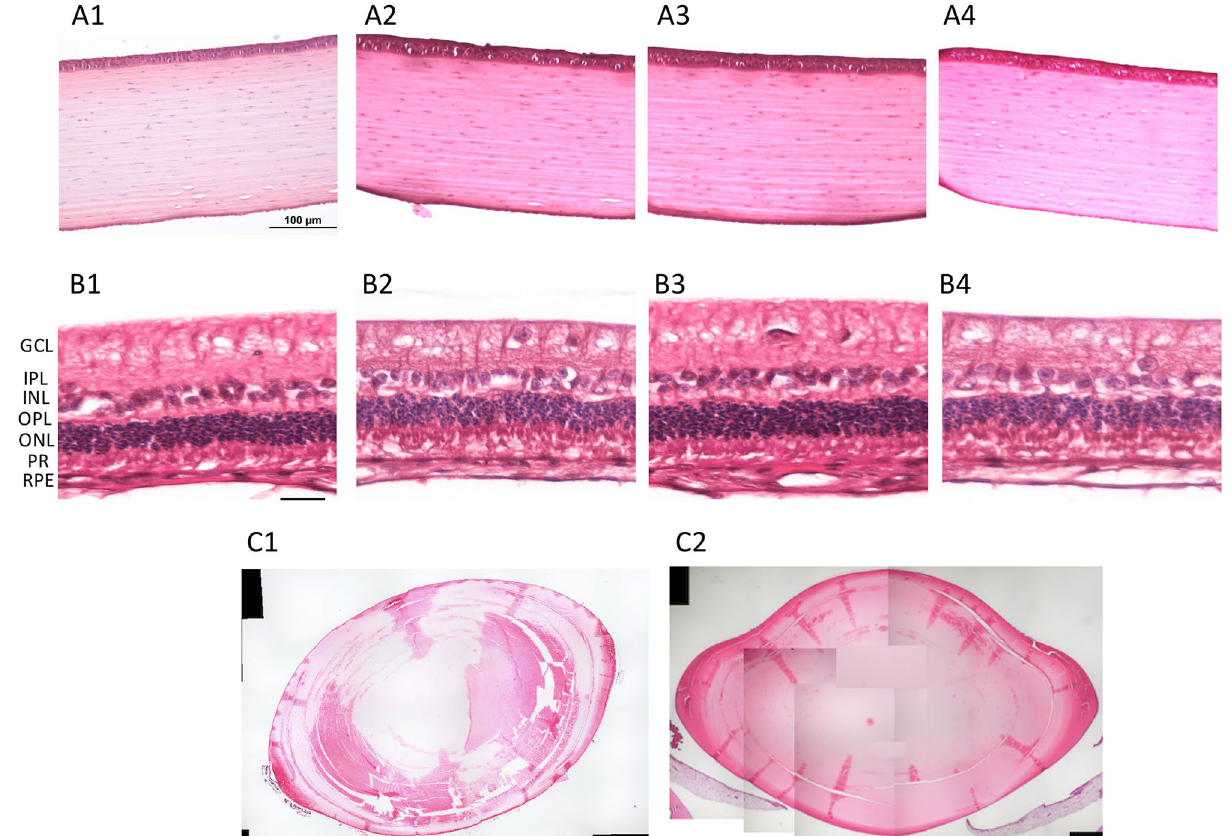
Figure 6. Histological sections with H&E staining presented that no inflammatory cell infiltrates or fibrotic reaction in the corneal stroma ( A1 – A4 ), and no retinal pathology such as gliosis, inflammation or degeneration of photoreceptors, were seen in the retinas ( B1 – B4 ), for the control, 1 h, 4 h and 1 week after 4 h-exposure groups, respectively. GCL: ganglion cell layer; IPL: inner plexiform layer; INL: inner nuclear layer; OPL; outer plexiform layer; ONL: outer nuclear layer; RPE: retinal pigment epithelium. After THz exposure, cataractogenesis was not detected. The crystalline lens fibers remained concentric and intact without disruption or liquefaction thus demonstrating no cortical cataract formation (note: artificial disruptions were seen due to processing artefacts). No increased coloration of the nuclear lens was seen thus excluding nuclear sclerosis ( C1 : control, C2 : 1 week after 4-h exposure). Scale bar: 100 μm.